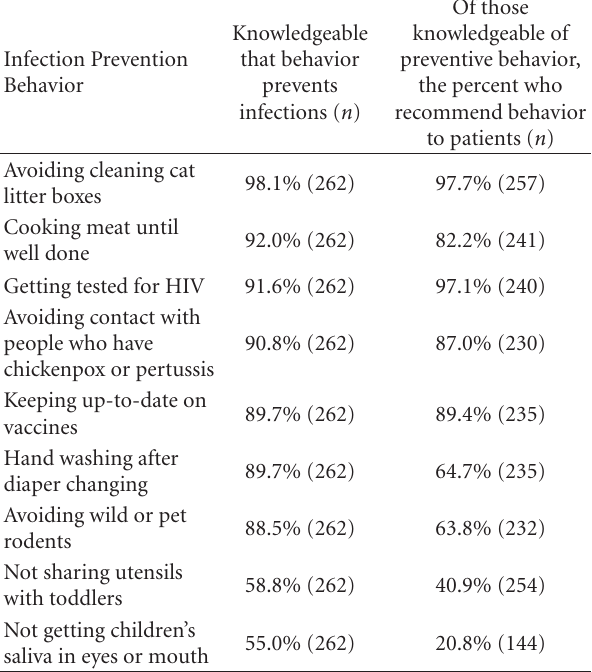
Table 1: Percentage of CARN respondents who reported knowing that various behaviors can prevent infection, and of those who reported knowledge of the preventive behavior the percent who reported recommending the behavior to reduce the risk of infection during